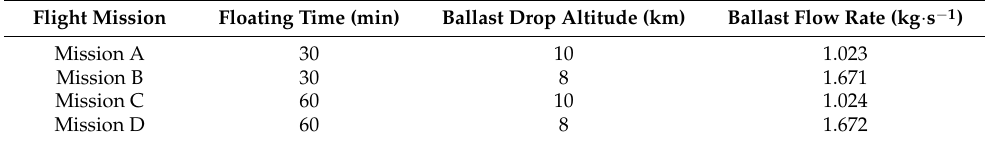
Table 2. Flight mission